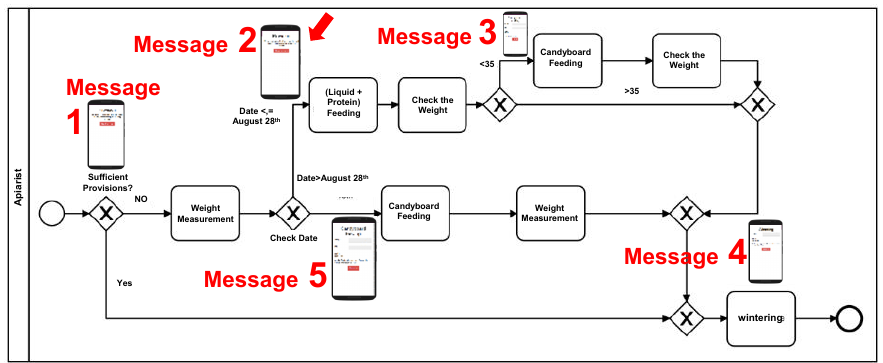
Figure 10. A Simple BPMN model illustrating simple apiarist work.